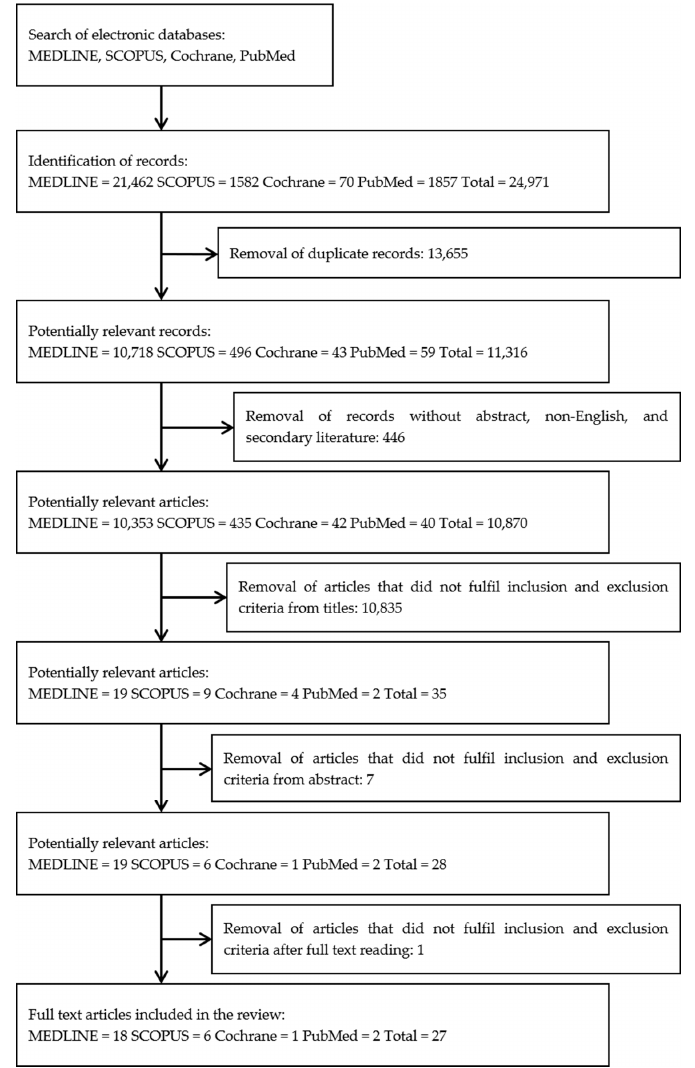
Figure 1. Flow chart of the selection procedure to identify relevant reports on honey’s cardioprotective effect.